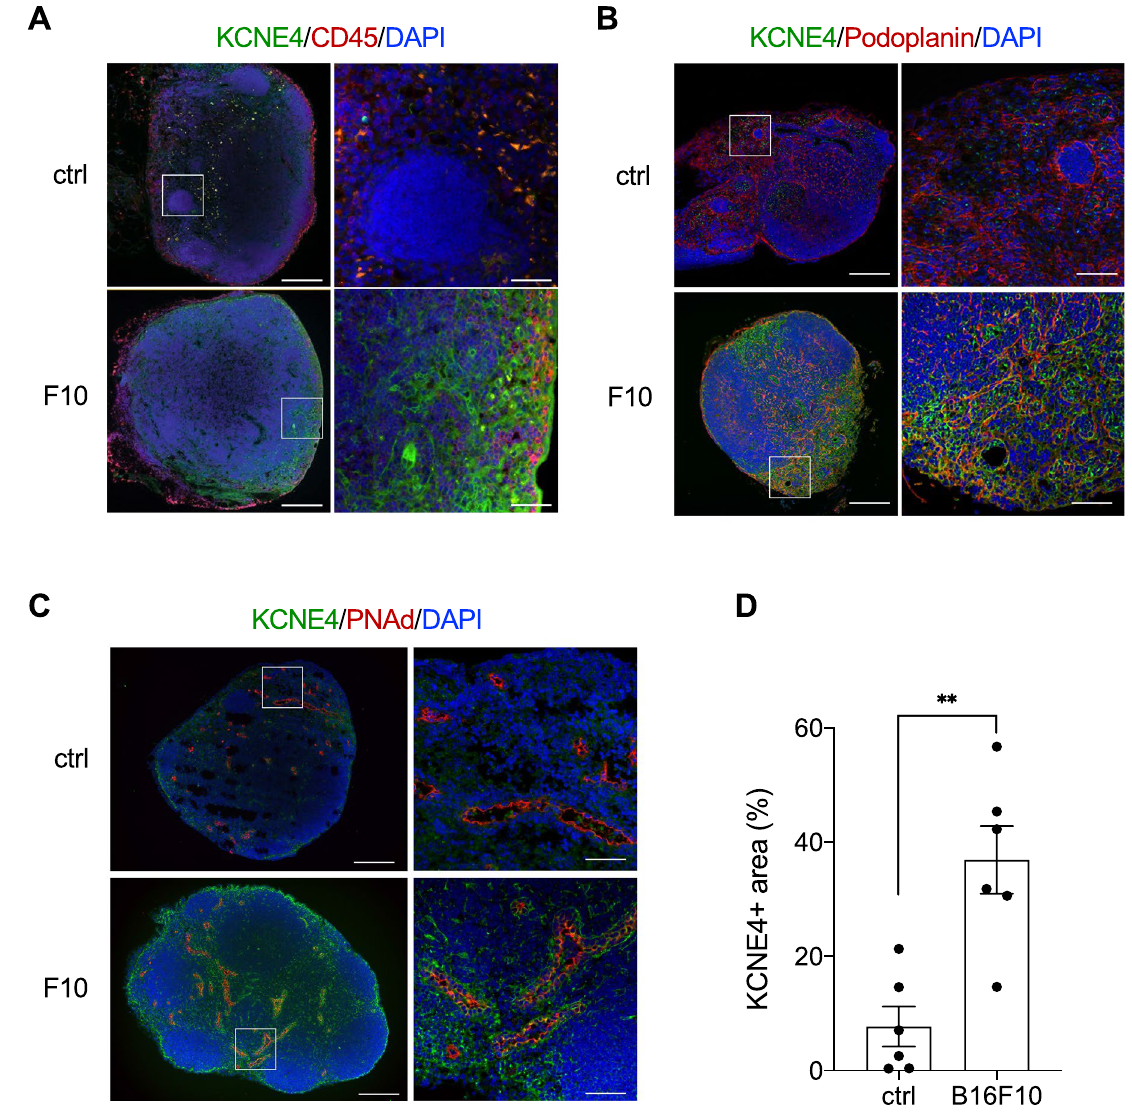
Figure 3. KCNE4 is upregulated by melanoma transplantation and is expressed on podoplanin-positive cells in SLNs. Expression of KCNE4 in SLN of mice transplanted with B16–F10 was examined by immunohistochemistry. Double staining was performed with anti-KCNE4 antibody and anti-CD45 antibody ( A ), anti-podoplanin antibody ( B ), and anti-PNAd antibody ( C ). Lymph nodes from mice injected with PBS were used as controls. Bars: 200 µm and 50 µm. ( D ) The percentages of KCNE4-positive areas in SLNs of ctrl or B16–F10 transplanted mice were measured by ImageJ software and divided by the area of the SLNs. Student’s t test, ** p <